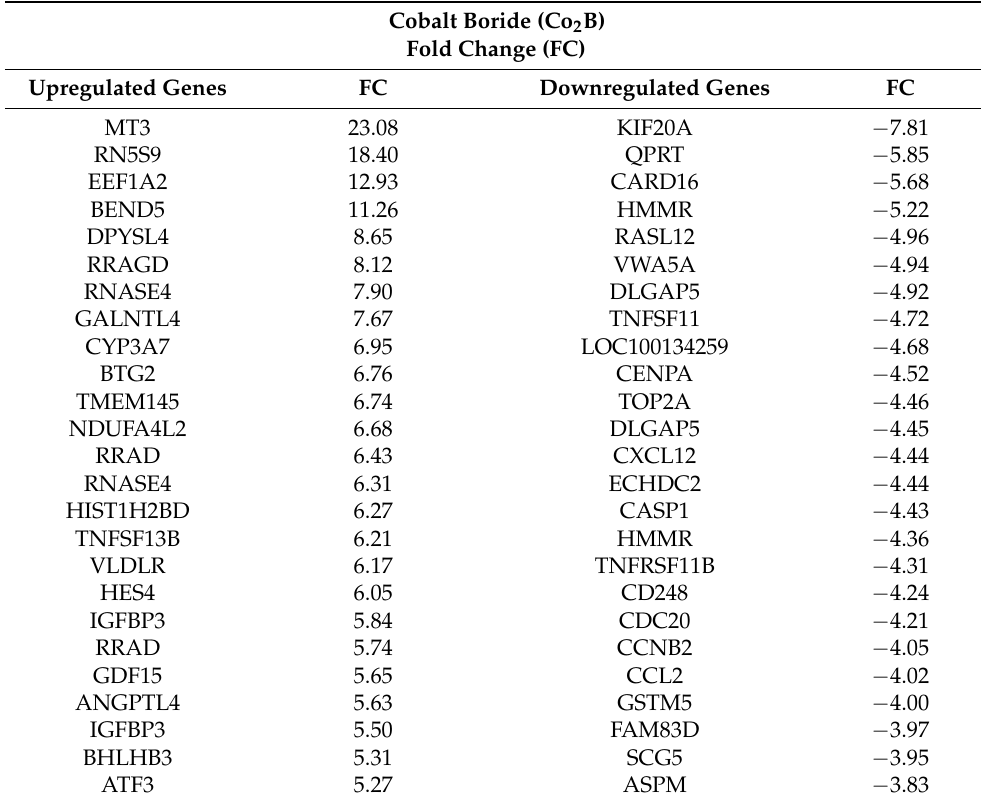
Table 1. A total of 25 upregulated and downregulated genes subject to cobalt boride (Co 2 B) NP